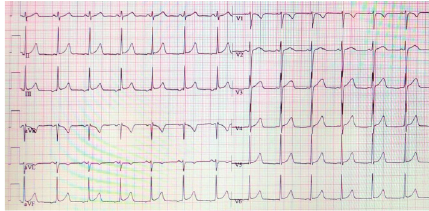
Figure 1: 12-Lead ECG from the patient.